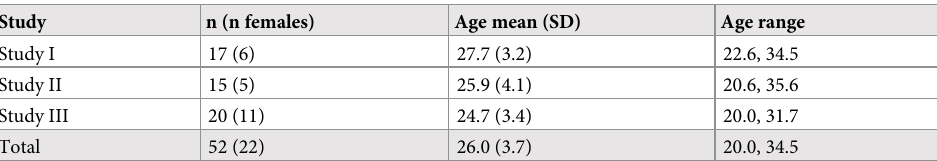
Table 1. Characteristics of the three